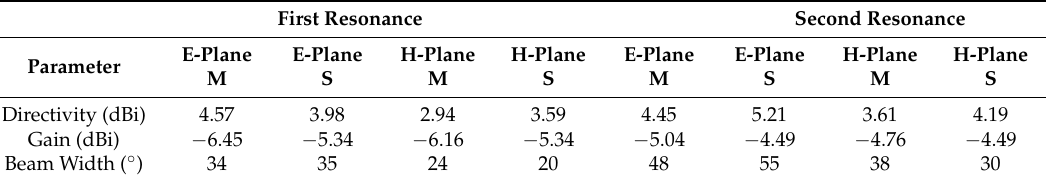
Figure 6. Radiation patterns of the TX antenna (dB) ( a ) E-plan at 2.5 GHz, ( b ) H-plan at 2.5 GHz, ( c ) E-plan at 4.5 GHz, ( d ) H-plan at 4.5 GHz. Table 3. Antenna specifications (M: Measurement, S: